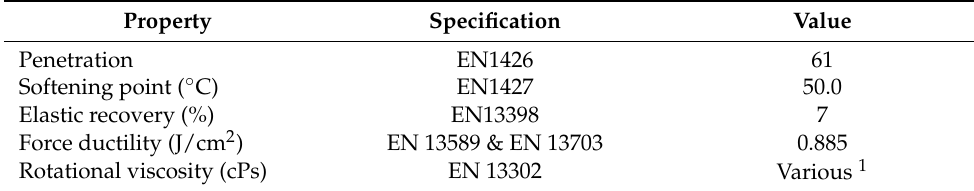
Table 1. Characteristic properties of reference bitumen.